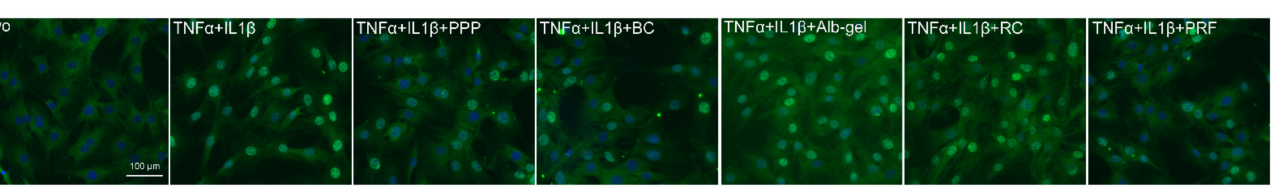
Figure 6. PPP, BC, and PRF could weaken phosphorylation of p65 in ST2 cells. Western blot analysis was carried out for phospho-p65 and total p65. ( A ) ST2 cells were treated with TNF α and IL1 β in the presence or absence of 10% of PPP, BC, Alb-gel, RC, and 30% of PRF lysates. ( B ) Data indicate the relative changes normalized to p65.